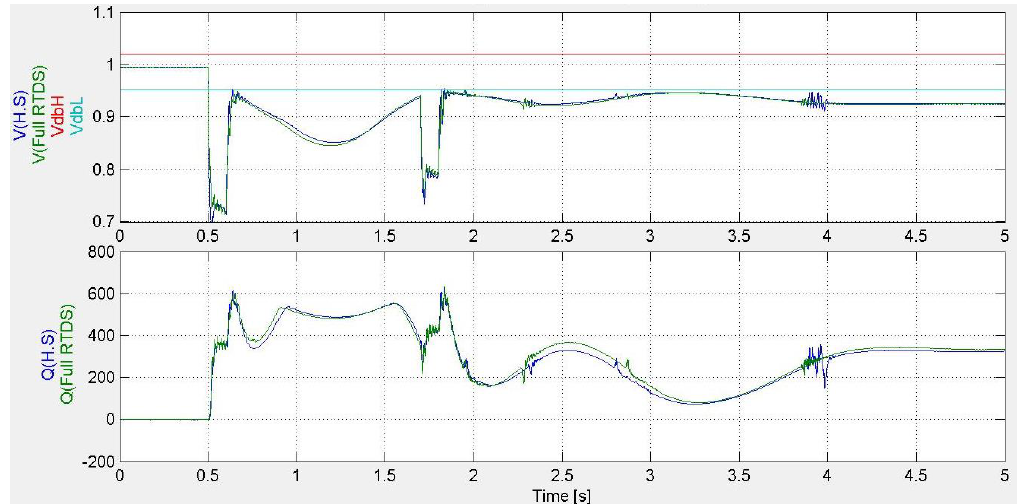
Figure 12. A 765 kV line fault is applied nearby Shin-Jecheon; Shin-Jecheon bus voltage (first row) and reactive power of SVC (second row); RTHS (blue line) and large-scale RTS (green line).